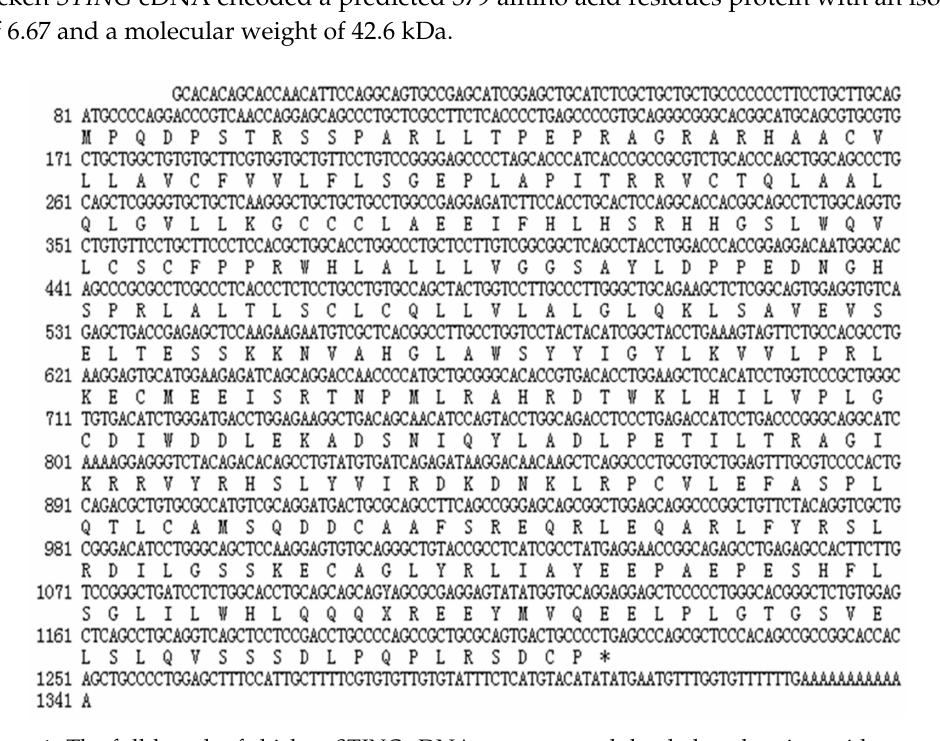
Figure 1. The full-length of chicken STING cDNA sequence and the deduced amino acid sequence. The stop codon is shown as “*”. The numbers refer to the nucleotide